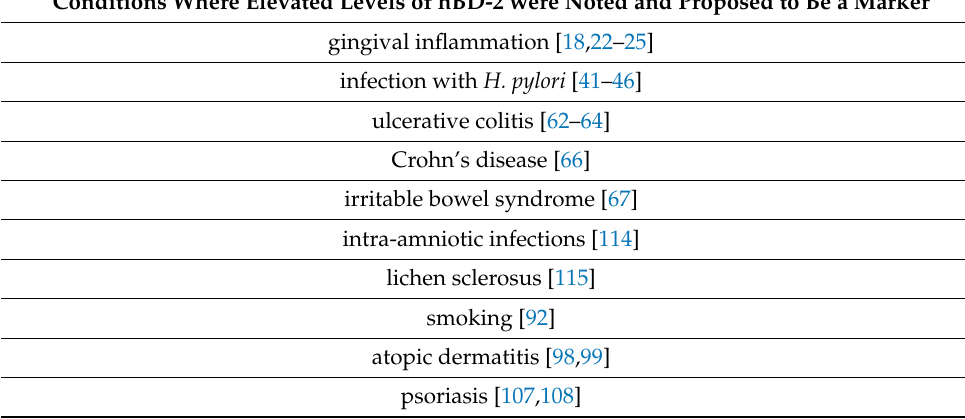
Table 2. Diseases in which hBD-2 may be a diagnostic